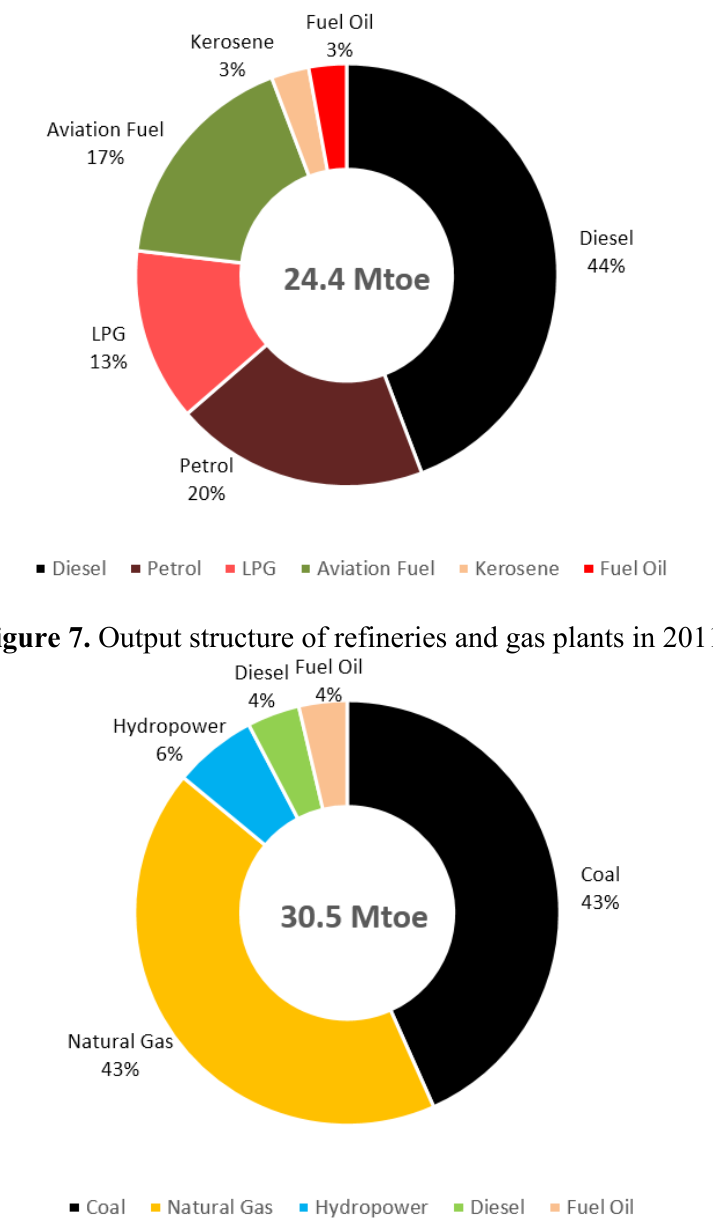
Figure 8. Input structure of power plants in Malaysia in